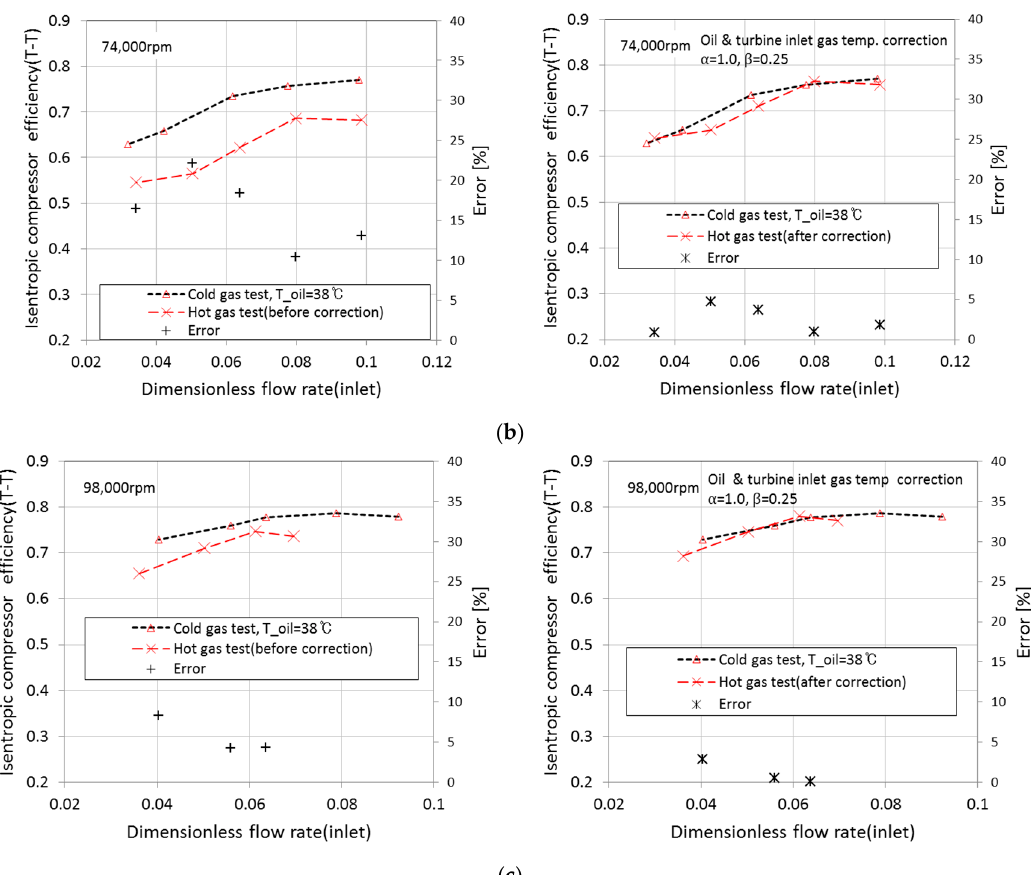
Figure 7. Results of the isentropic compressor efficiency correction for oil inlet temperature and turbine inlet gas temperature. ( a ) compressor speed at 52,000 rpm; ( b ) compressor speed at 74,000 rpm; ( c ) compressor speed at 98,000 rpm.